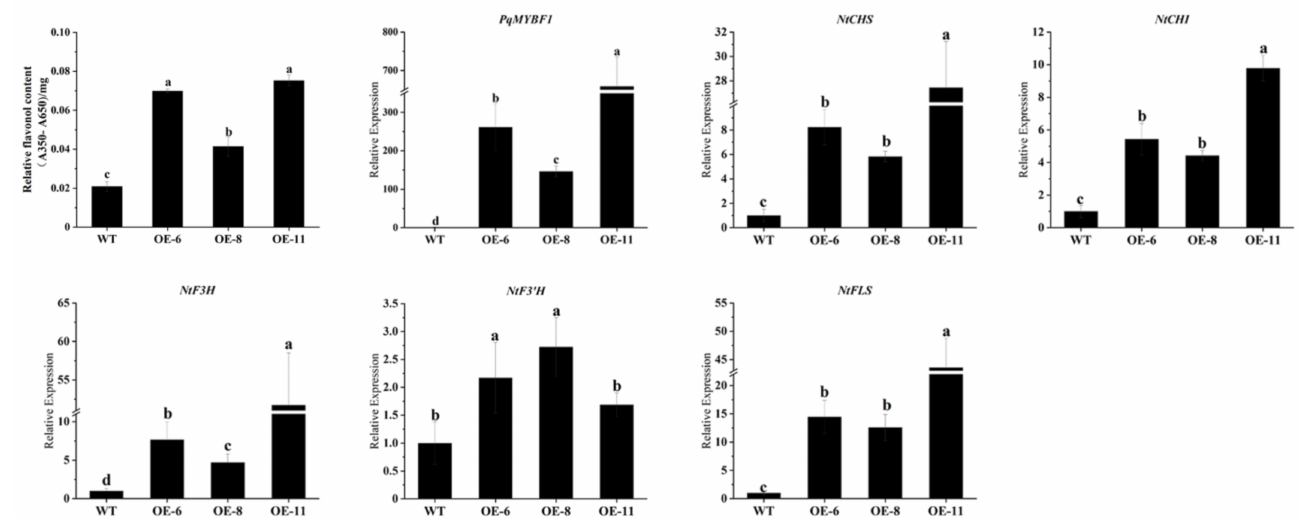
Figure 5. The expression profiles of vital flavonol biosynthesis pathway genes in PqMYBF1 overex- pression transgenic tobacco leaves. a, b, c, and d indicate significant differences at the p ≤ 0.05 level in the Duncan test.